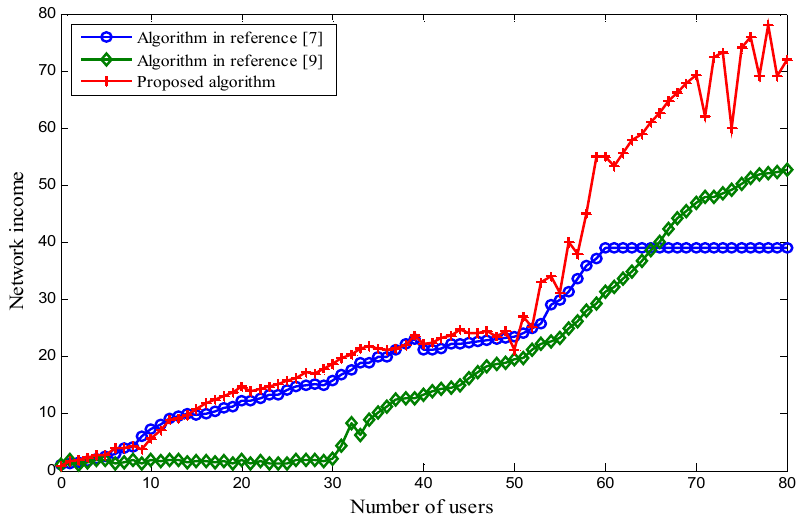
Figure 8. The integrated network income.